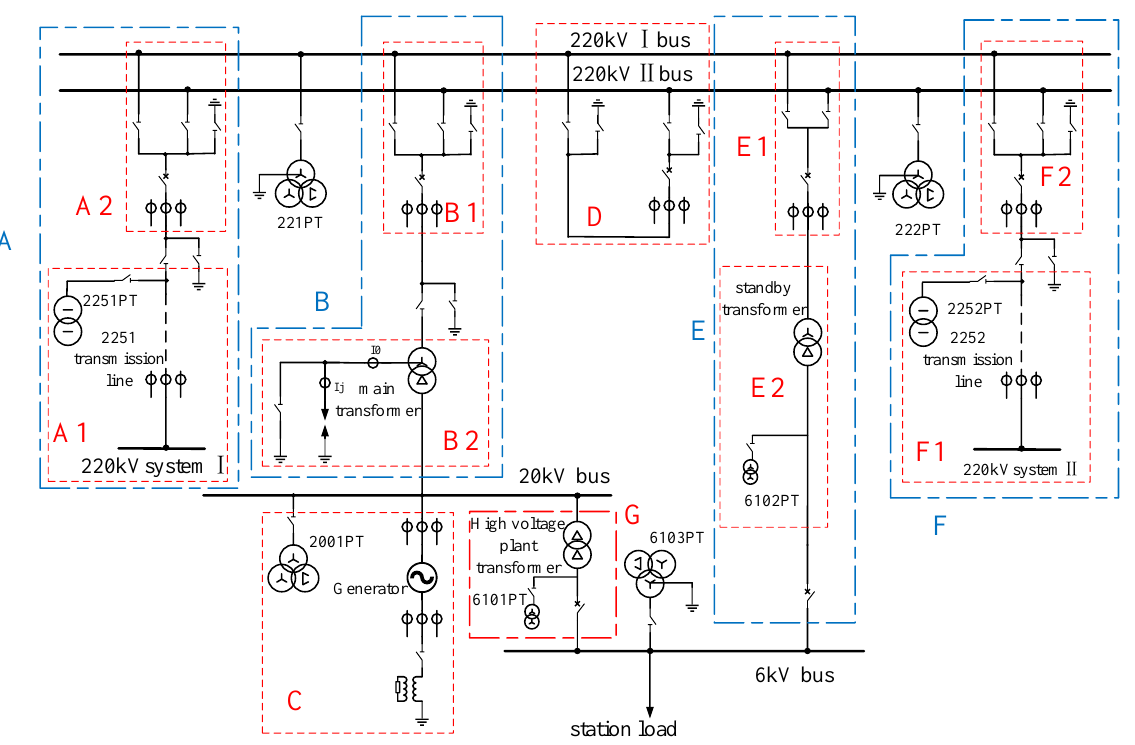
Figure 11. Schematic diagram of the generator–transformer group-boost station.